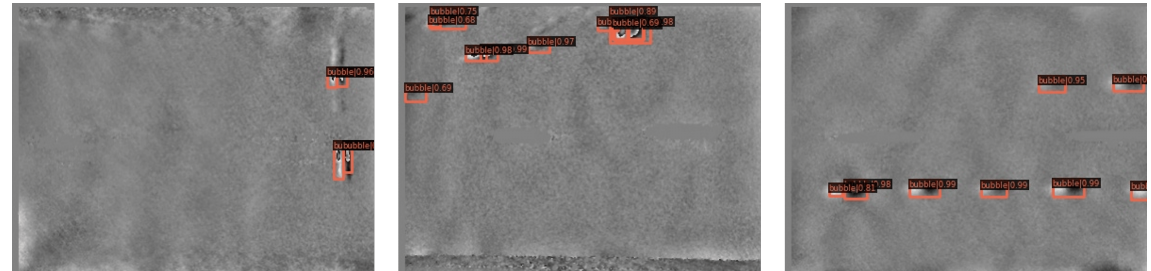
Figure 11. Detection results of